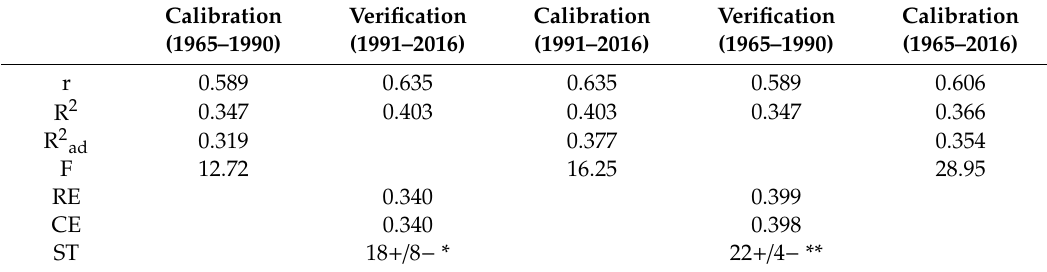
Table 1. Calibration and verification statistics for the tree-ring reconstruction of the June Palmer Drought Severity Index